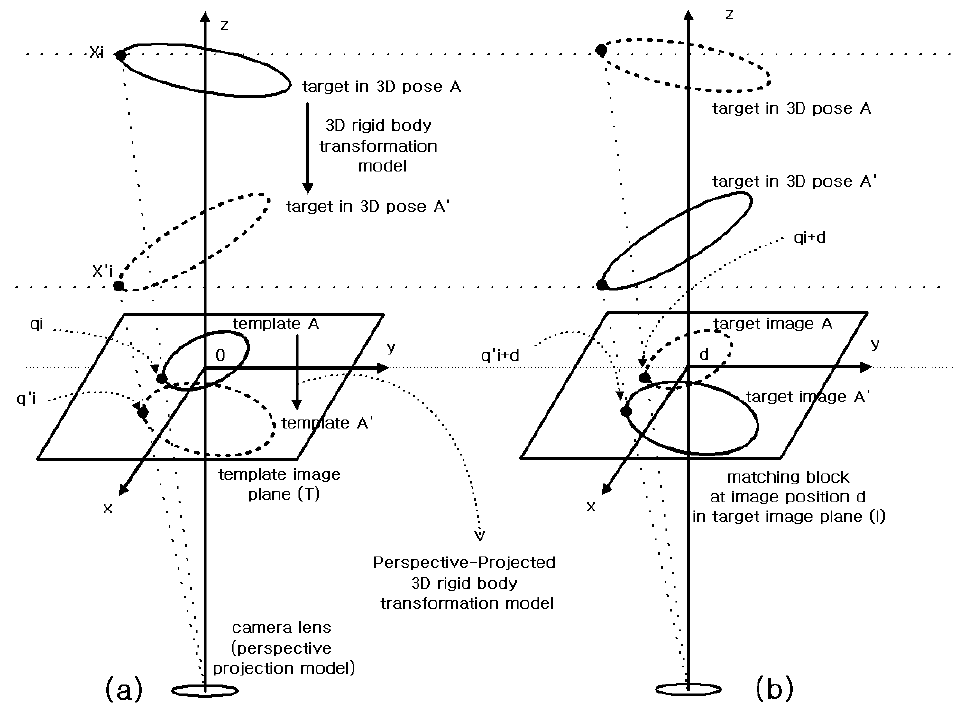
Figure 2. Perspective-Projected 3D rigid body transformation model for block matching of template A to target image A’ ( X (cid:48) i − X i = ∆ X i , q (cid:48) i − q i = ∆ q i ): ( a ) template A is a photograph of a target with a 3D pose A. ( b ) target image A’ is a photograph of target with a 3D pose